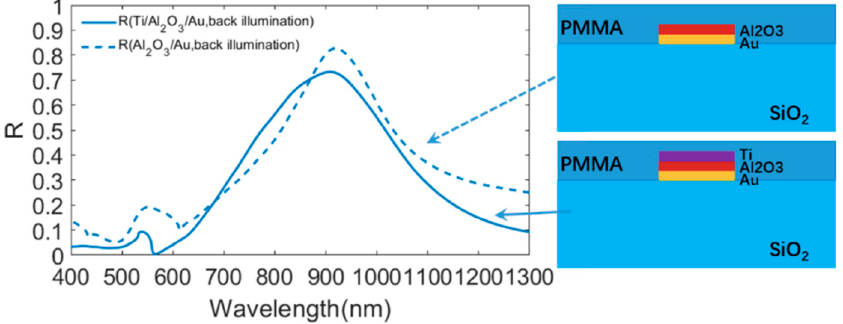
Figure 3. Comparisons of reflection spectra between the metasurface consisting of Ti/Al 2 O 3 /Au and the metasurface consisting of Al 2 O 3 /Au upon back illumination.